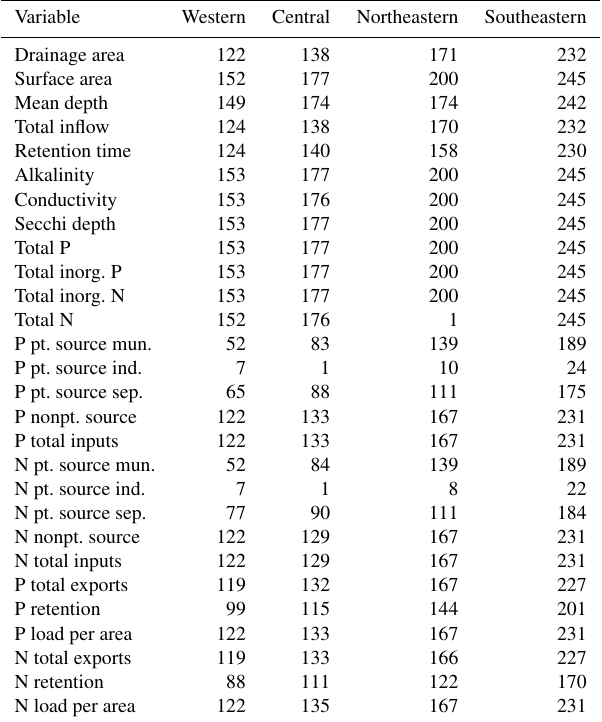
Table 1. Number of measurements ( n ) for each variable in each NES region.